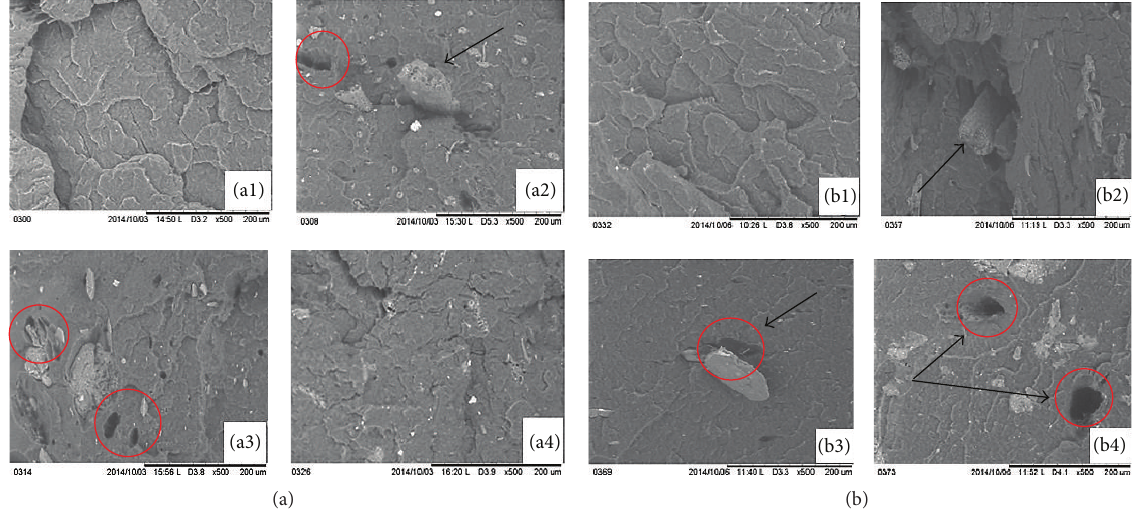
Figure 5: SEM micrographs of fractured surfaces (a) before aging and (b) after aging for composites: ((a1), (b1)) virgin PP, ((a2), (b2)) F20UT, ((a3), (b3)) F20AT, and ((a4), (b4))